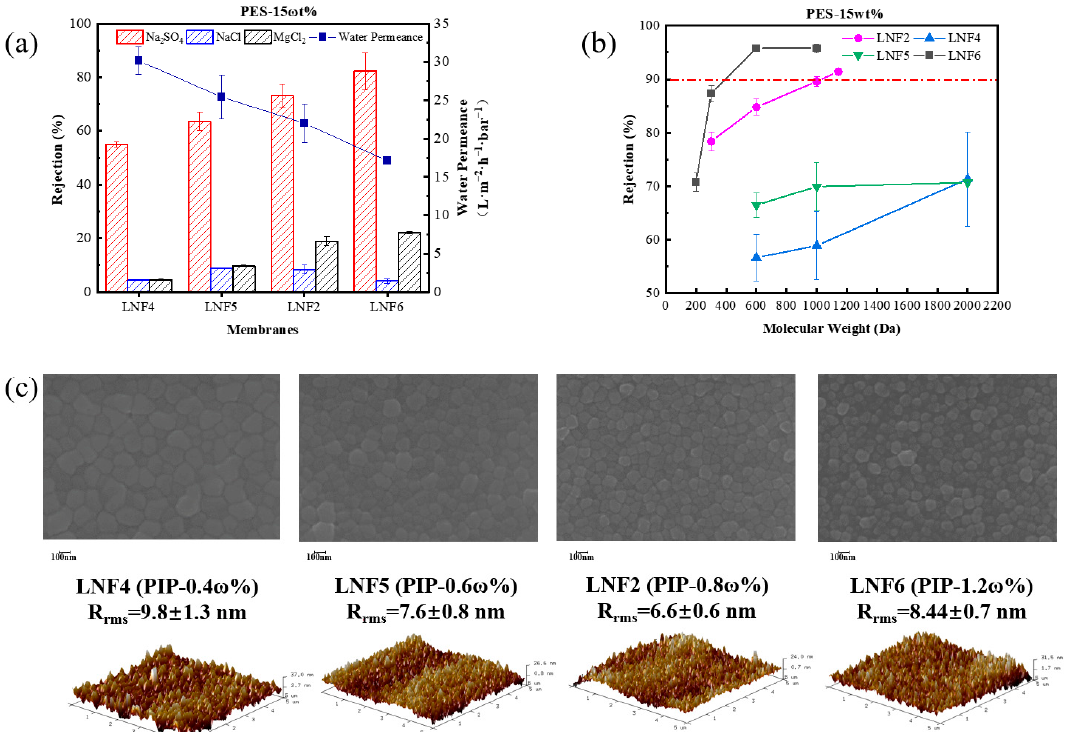
Figure 3. Effect of PIP concentration in the cast solution on the performance and properties of the TFC LNF membranes. The PES concentration in the cast solution was fixed at 15%. ( a ) Water permeance and rejections of Na 2 SO 4 , NaCl and MgCl 2 . ( b ) Rejections of PEGs with different molecular weights. ( c ) Membrane surface morphology depicted by SEM and AFM